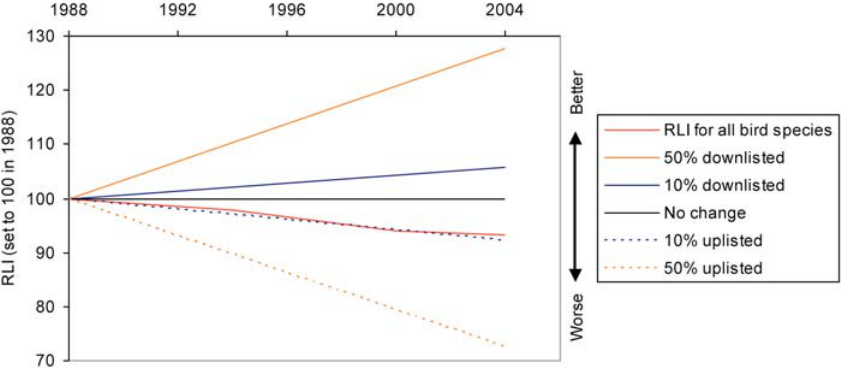
Figure 2. The RLI for All Bird Species in 1988–2004 Compared to Hypothetical In- dices